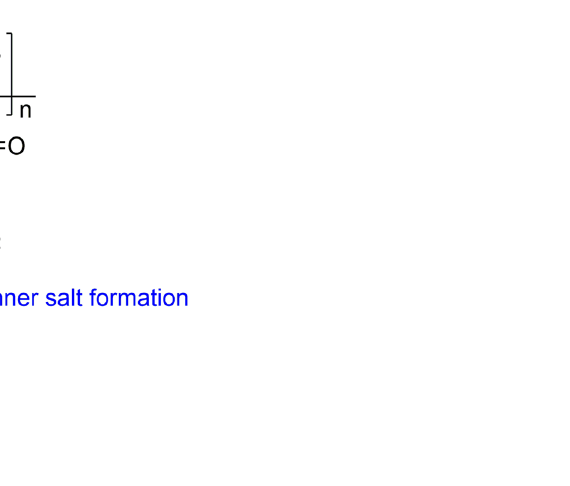
Figure 2. Hydrophobic hydration of polymerized MPC under inner salt formation indicated by blue